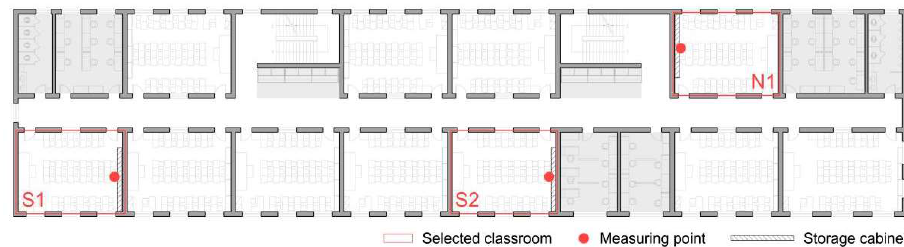
Figure 3. S1, S2 and N1 location on the 4th floor and the measurement points in the classrooms.